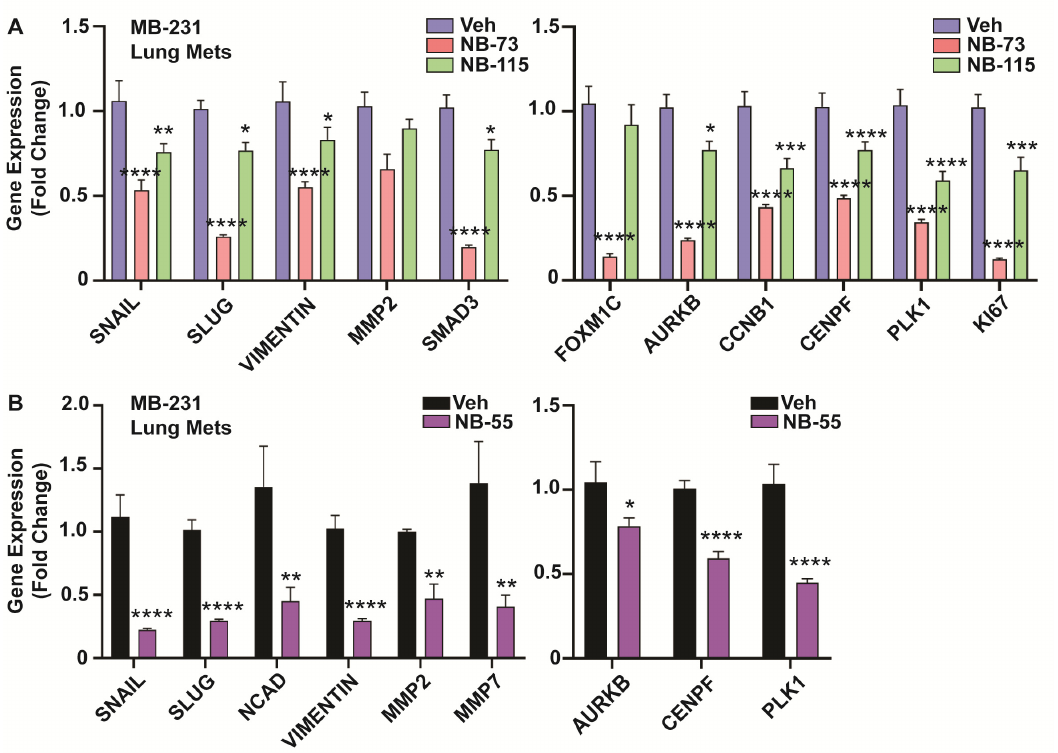
Figure 7. Gene expression analyses in TNBC lung metastatic lesions, Metastatic foci in the lung tissues from all animals in the compound- and vehicle-treated groups were harvested at the end of the study, followed by RNA isolation and qPCR analysis for EMT markers and known FOXM1 regulated cell cycle target genes. ( A ) Treatment with NB-73 and NB-115 or ( B ) NB-55 resulted in significant downregulation of the mRNA for different EMT markers and FOXM1 regulated genes. (2-way ANOVA, Dunnett’s post-test, * p < 0.05, ** p < 0.01, *** p < 0.001, **** p < 0.0001; values are mean ± SEM).